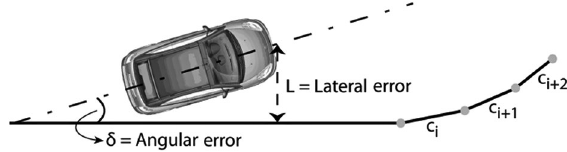
Fig. 5. Input variables defined for lateral control